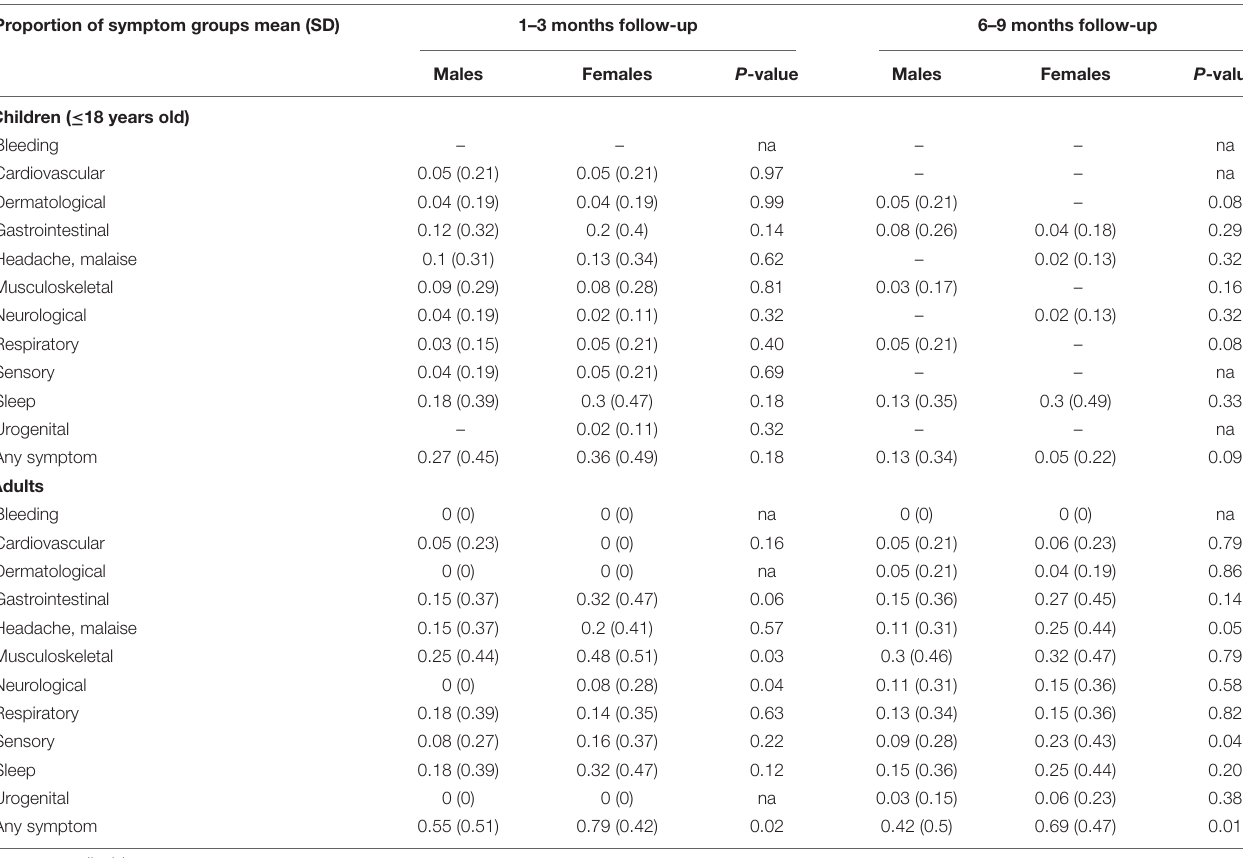
TABLE 4 | Comparison of symptom proportions by gender stratified by follow-up time period in children and adults. Proportion of symptom groups mean (SD)